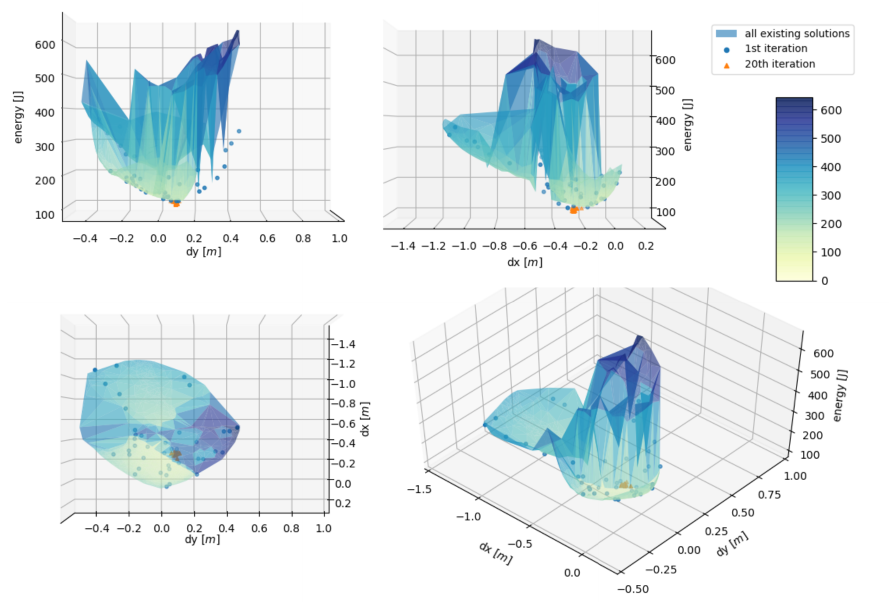
Figure 12. Specific energy in terms of the displacement vector of the robot base [dx,dy] .